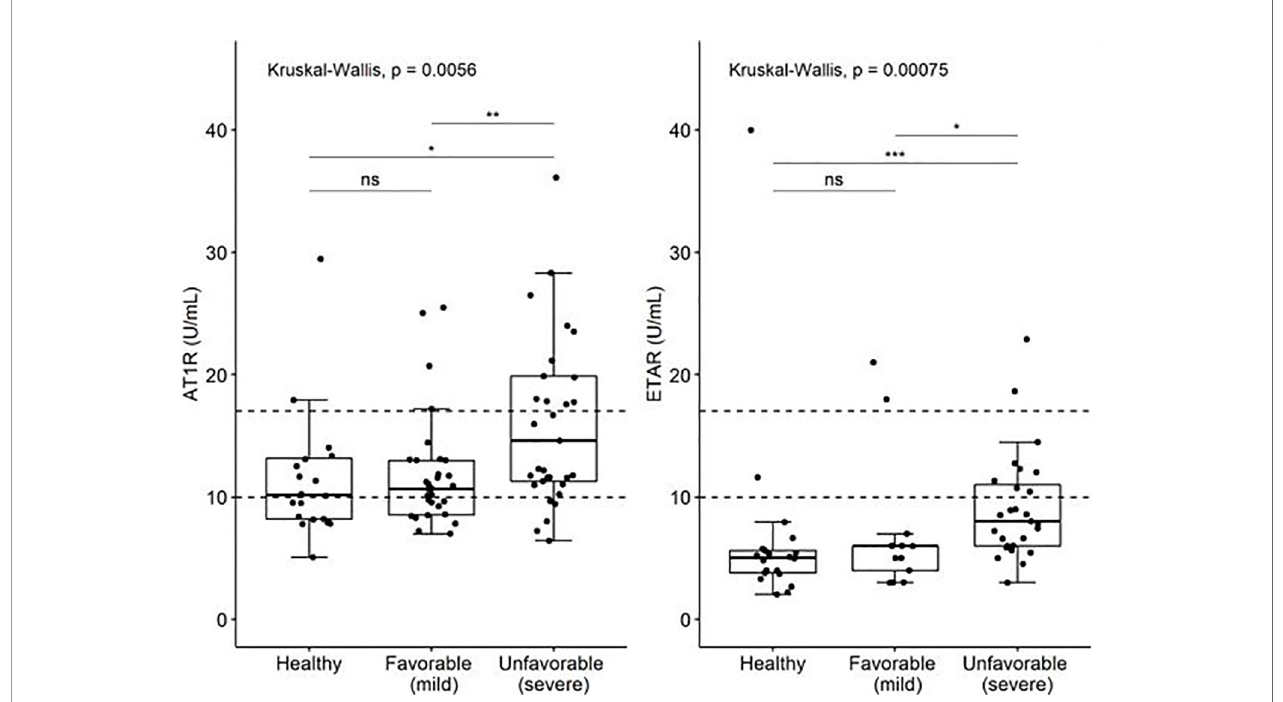
FIGURE 1 | Levels of auto-antibodies against AT1R and ETAR (U/ml) in COVID19 patient with favorable and unfavorable disease course and age matched controls. The limits of the axes in the graph are placed at 45 U/ml. Three values of AT1R are outside the range of the graph; they are included in the analysis. P-values: ns, not signi fi cant (>0.05), "*" <0.05, "**" <0.01,